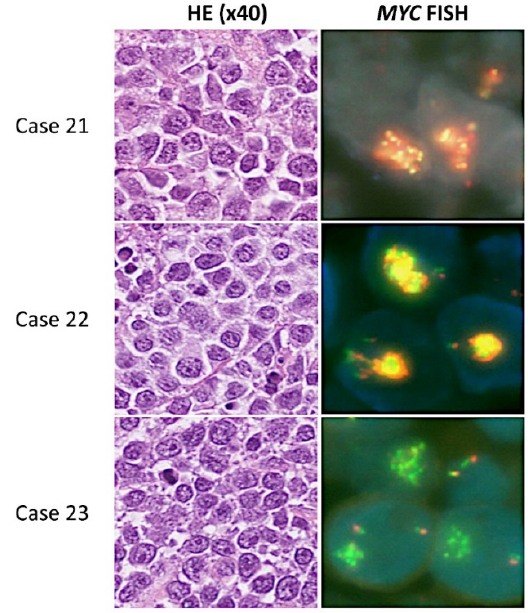
Figure A1. Histology and FISH of diffuse large B-cell lymphoma with MYC-cluster amplifica-tion (MCAD).